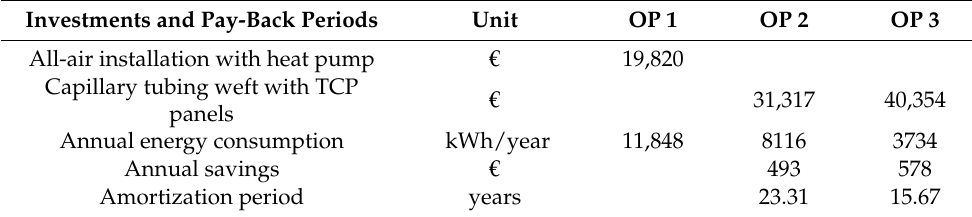
Table 11. The calculation of the investment amortization period of OP 3 compared to OP 2. Investments and Pay-Back Periods Unit OP 1 OP 2 OP 3 All-air installation with heat pump € Capillary tubing weft with TCP